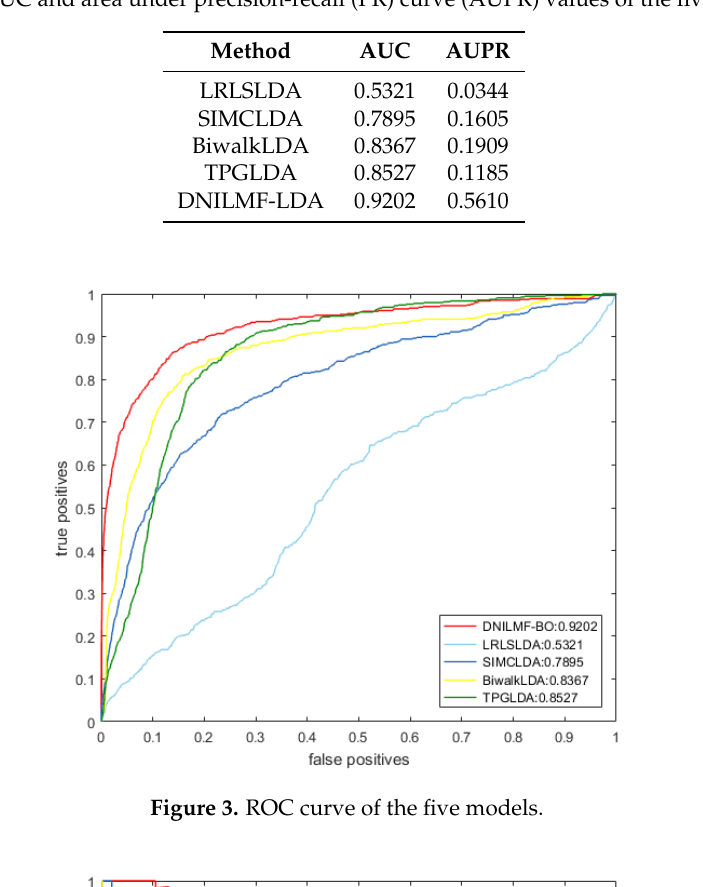
Figure 3. ROC curve of the five models.